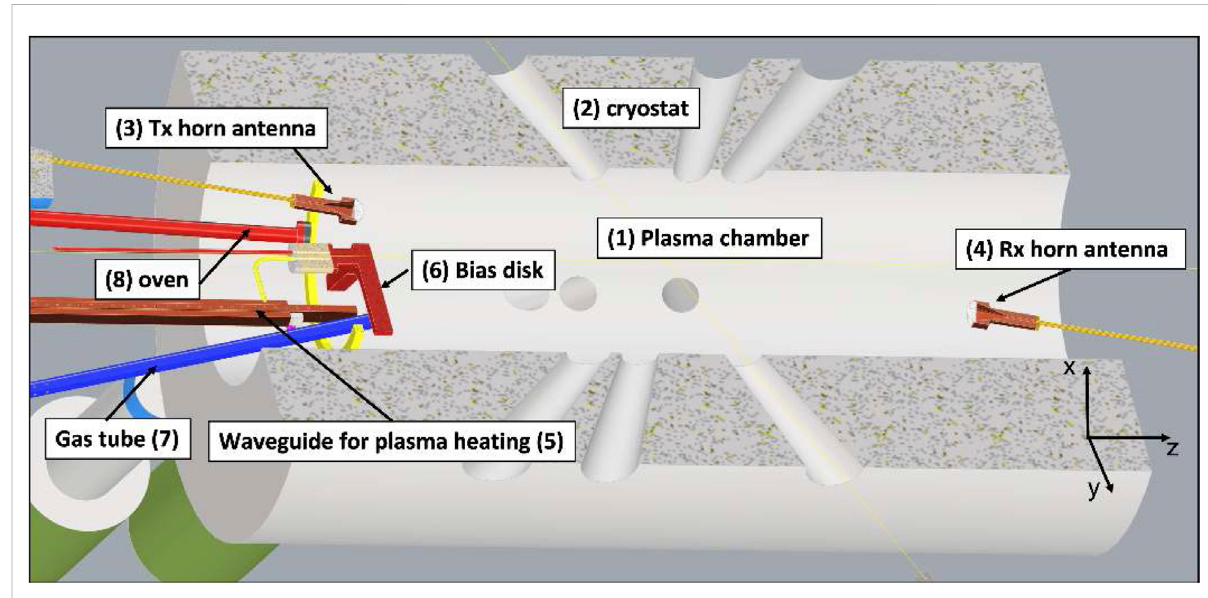
FIGURE 4 Cross-sectional view of the PANDORA plasma chamber (1) which will be installed inside the visible bore of the cryostat (2): the two horn antennas (3) and (4) are placed co-aligned and directed towards the plasmoid center. Plasma is heated through 5 kW microwave coming from rectangular waveguides, one is shown (5). Morever in the view it is shown: the bias disk (6) electrode negatively biased with respect to the source potential for ion beam current increase; the gas injection tube (7) for gaseous element production; the oven (8) for producing ions of metallic